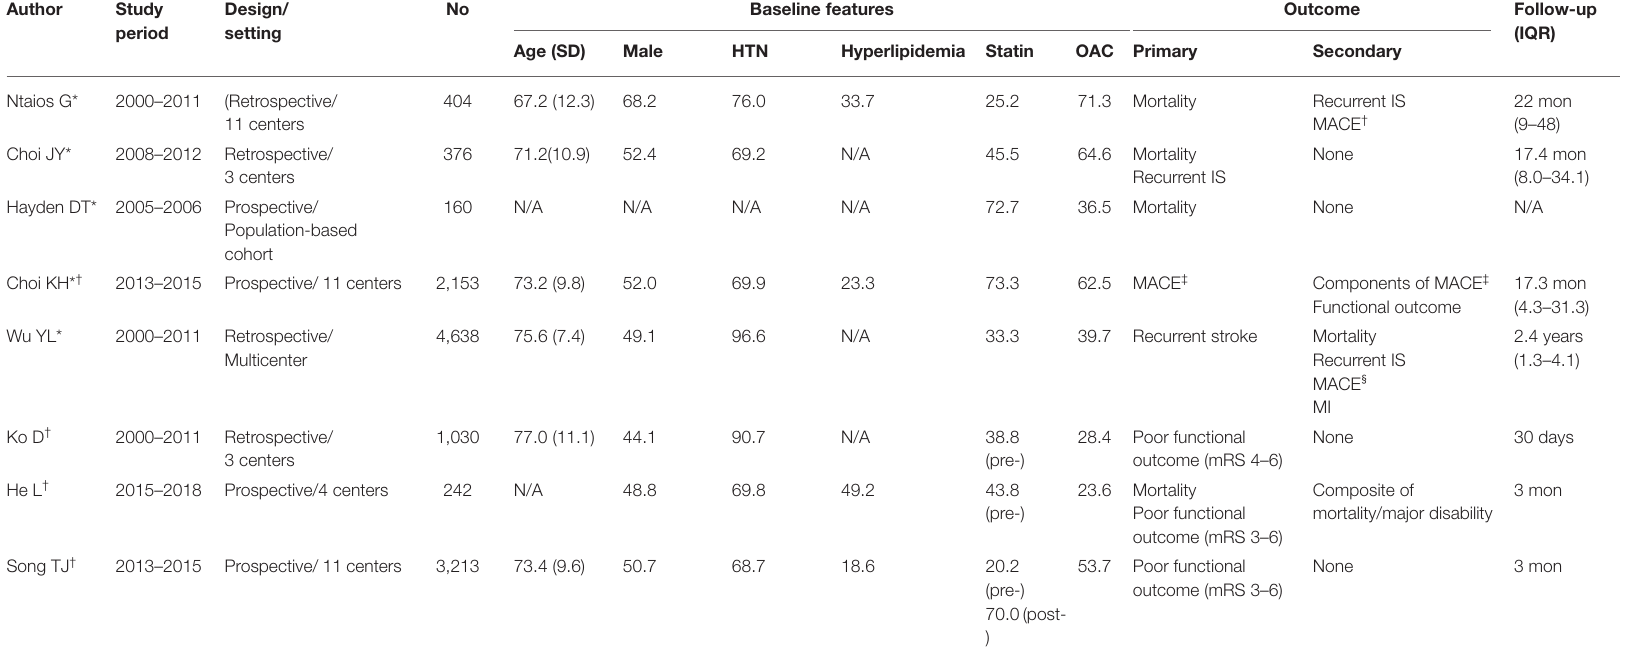
TABLE 1 | Characteristics of included